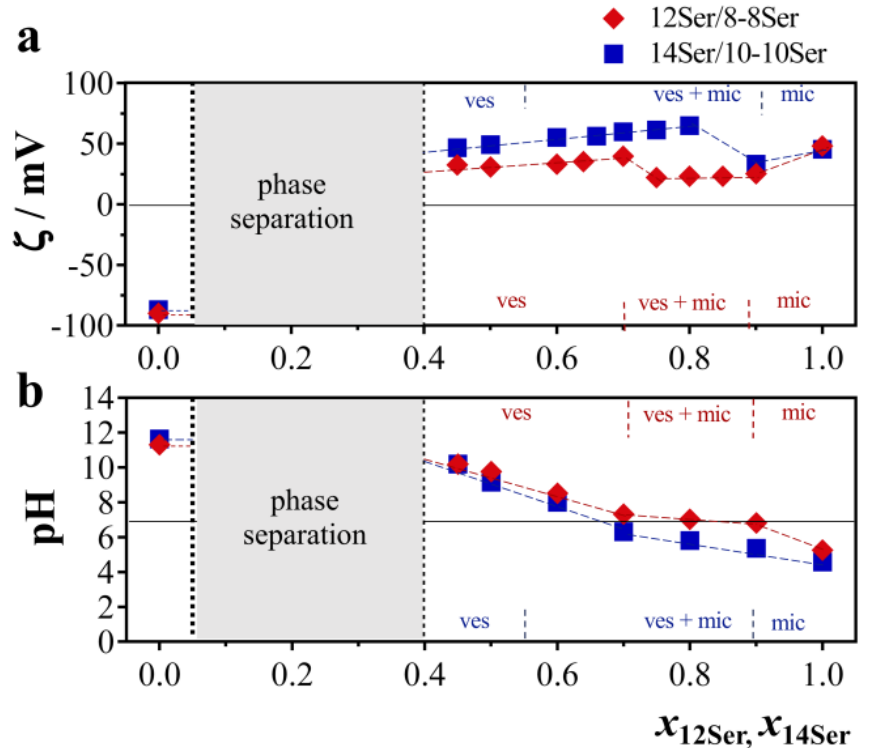
Figure 4. Zeta potential ( a ) and pH ( b ) of 12Ser/8-8Ser and14Ser/10-10Ser catanionic mixtures, at 0.5 wt% total surfactant and 25 °C.